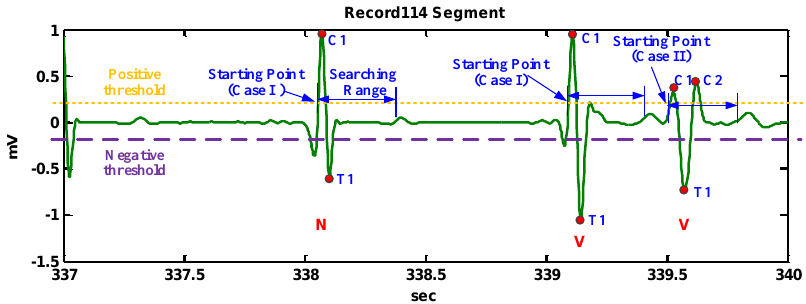
Figure 8. The demonstration of QRS fiducial point detection for the Record 114 segment.